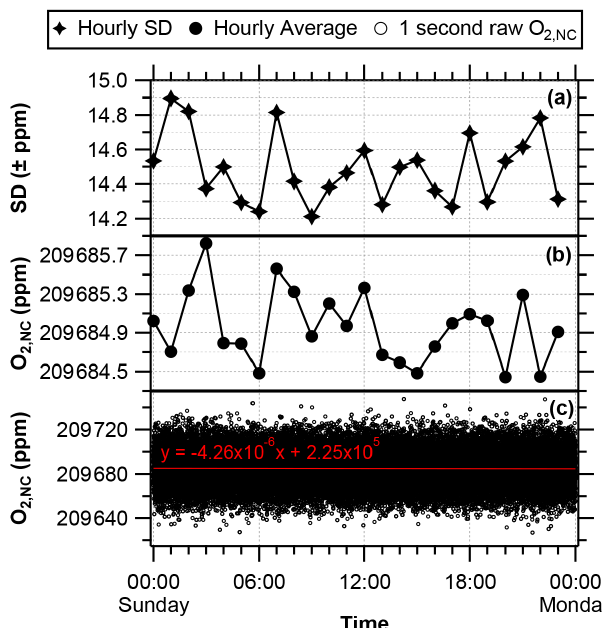
Figure 3. O 2 , NC mole fractions from the G2207- i sampling dry compressed cylinder air over 24h (reported in ppm, where 1ppm corresponds to a change of 4.8 per meg in the O 2 / N 2 ratio). (a) Standard deviation of the hourly averaged values. (b) Hourly averaged O 2 , NC . (c) Raw 1s O 2 , NC values, the red line depicts the linear regression line, with the equation and R 2 value written